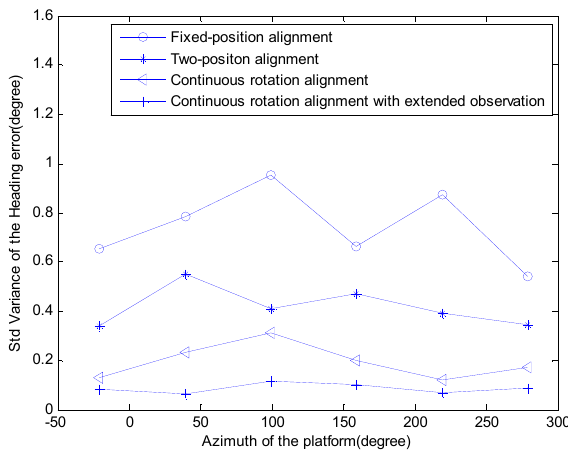
Figure 7. The accuracy of the system using four approaches.